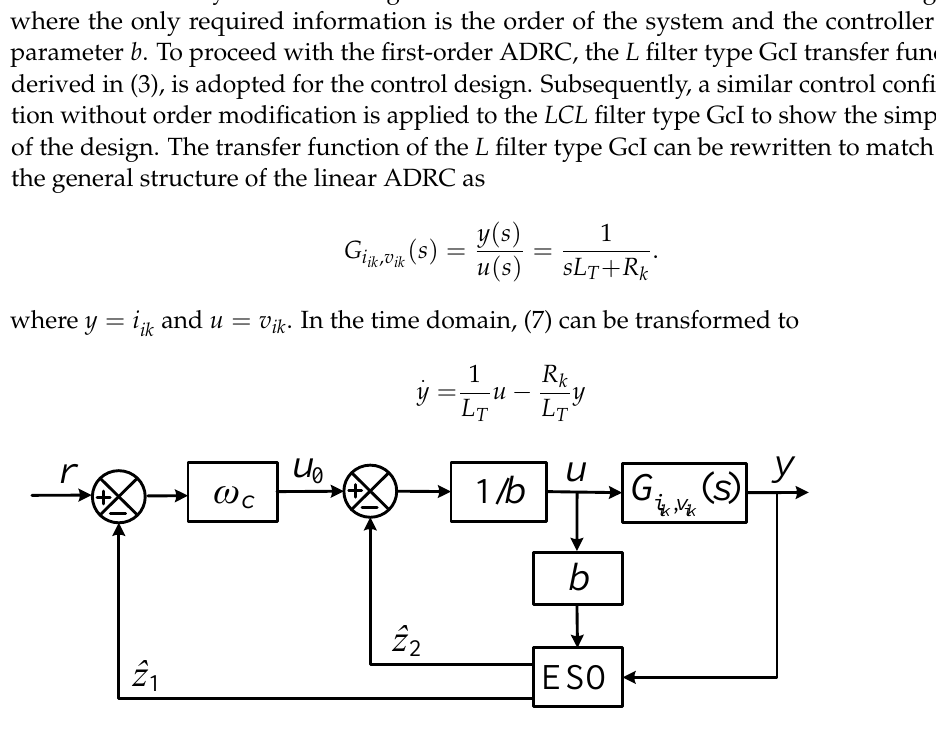
Figure 7. General block diagram of the first-order linear ADRC, adapted with permission from [22], Copyright 2021 Elsevier.